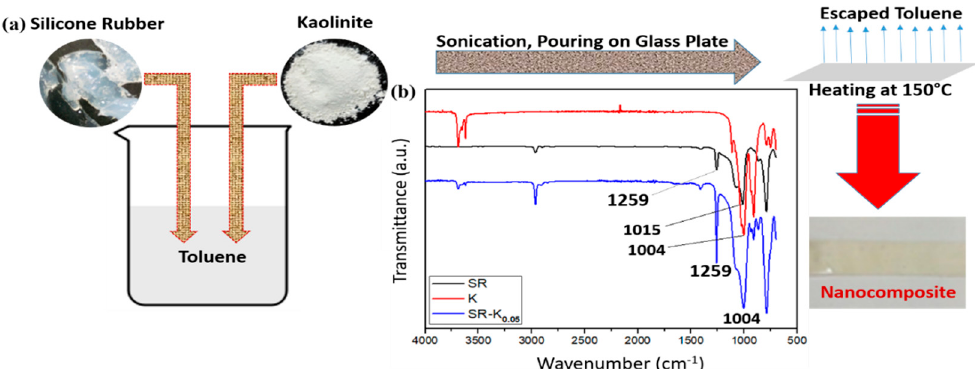
Figure 1. ( a ) A simplified scheme for NCP preparation (loading of kaolinite led to the formation of optically opaque composite films), ( b ) FTIR spectra of SR, K, and SR-K 0.05 (only the significant peaks are highlighted for comparison purpose). The characteristic absorption band at 1015 cm − 1 (SR) overlapped with 1004 cm − 1 (K) and broadened, indicating surface chemical interaction between filler and matrix.